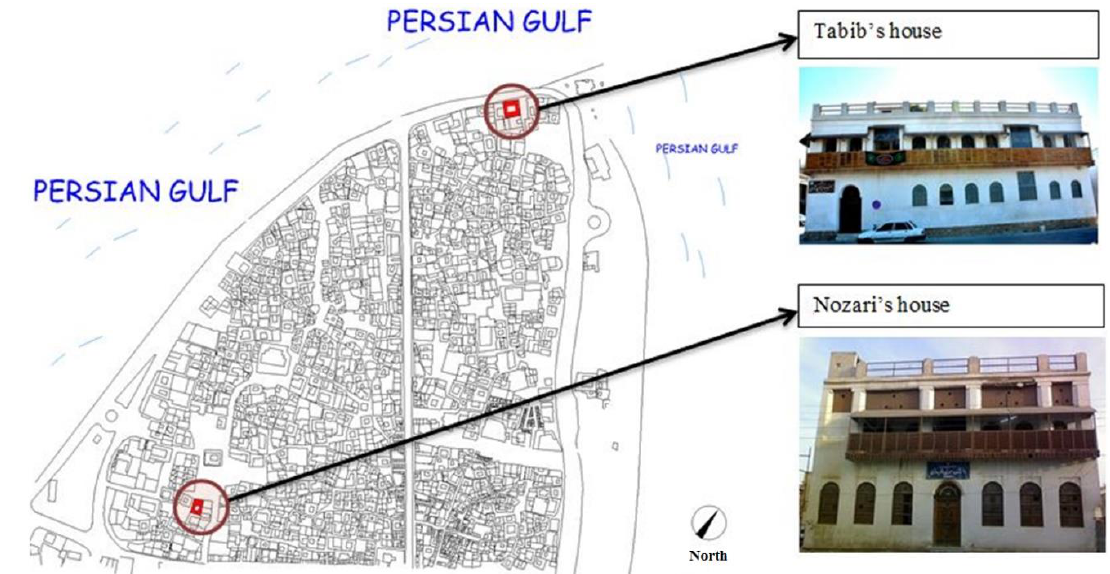
Figure 1. Location of Tabib’s and Nozari’s houses in Bushehr , Iran representing traditional architecture.